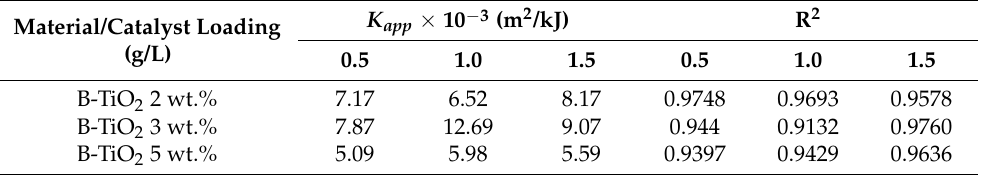
Table 2. Reaction kinetic parameters using B-doped TiO 2 catalysts.